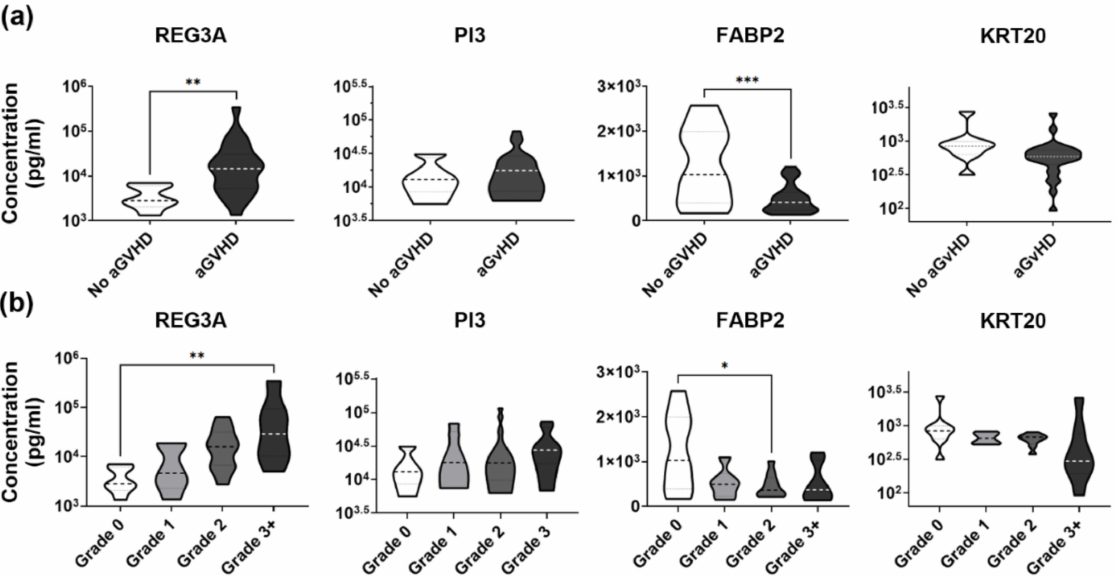
Figure 3. Plasma levels of select plasma proteins under the influence of aGvHD development and disease severity, as measured at the time of diagnosis, by ELISA assays. ( a ) Concentration of four plasma proteins depending on the presence and absence of aGvHD ( t -tests, stars indicate signifi- cance; ** p < 0.01, *** p < 0.001). ( b ) Relationship between plasma protein concentration and GvHD severity, as measured by grade (One-Way ANOVA, stars indicate results of post hoc tests; * p < 0.05, ** p <